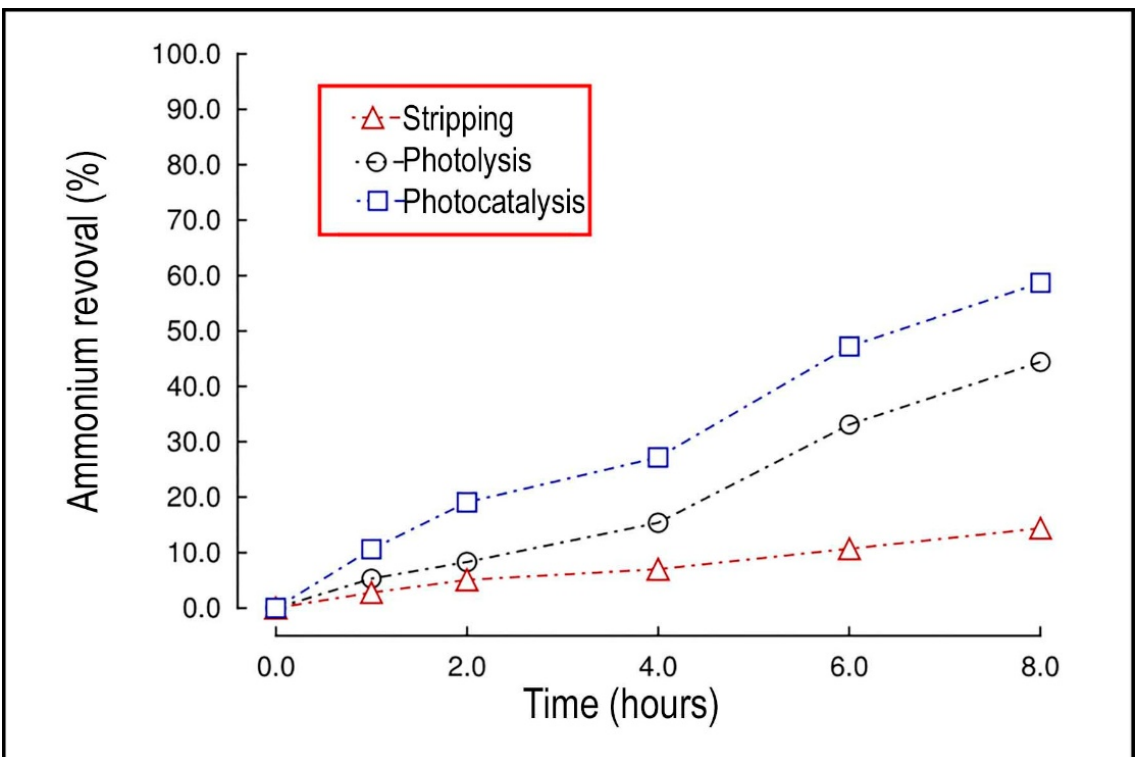
Figure 5. Percentage of ammonia removed vs. time by photolysis (o), photocatalysis ( (cid:3) ) and stripping ( ∆ ) treatments at pH = 11.0, 25 W UV-C lamp. Q = 1000 L/h, temperature = 20 ± 1 ◦